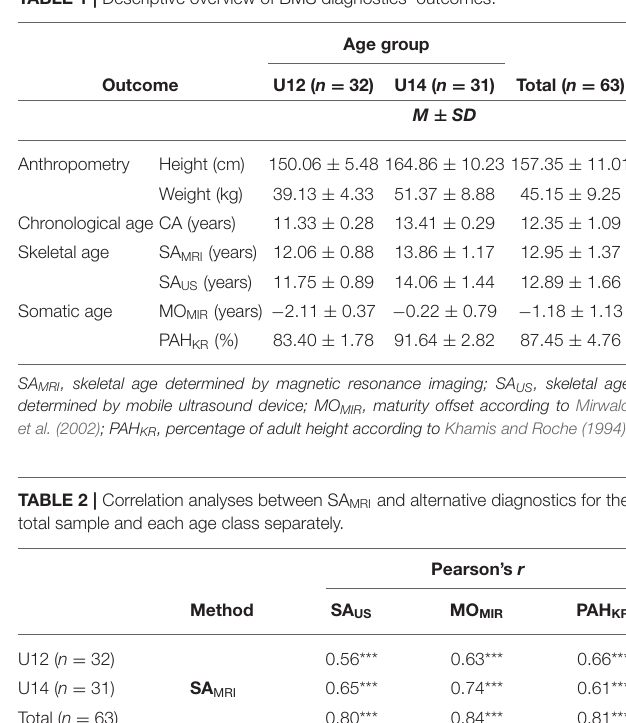
TABLE 1 | Descriptive overview of BMS diagnostics’ outcomes.